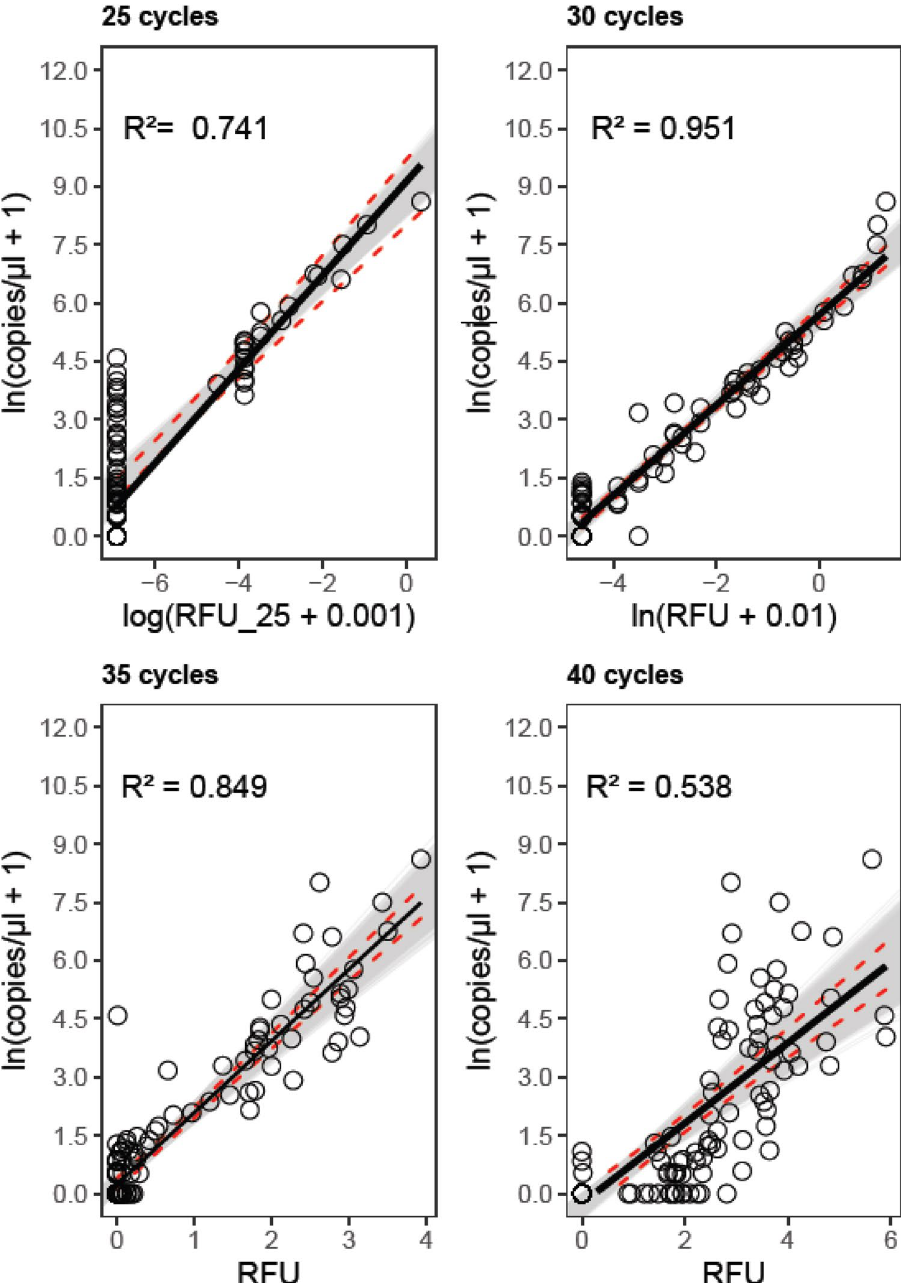
Figure 4. Correlations of plant-specific trn L-target copies/µl DNA extract and signal strength (RFU) of celPCRs products after 25, 30, 35 or 40 cycles with a reaction volume of 10 µl. Dots ( ○ ) are measured values, black bold lines are predicted values of linear regression models, dashed lines are 95% confidence intervals, shaded area are boot-strapped 95% confidence intervals and R 2 indicates goodness of